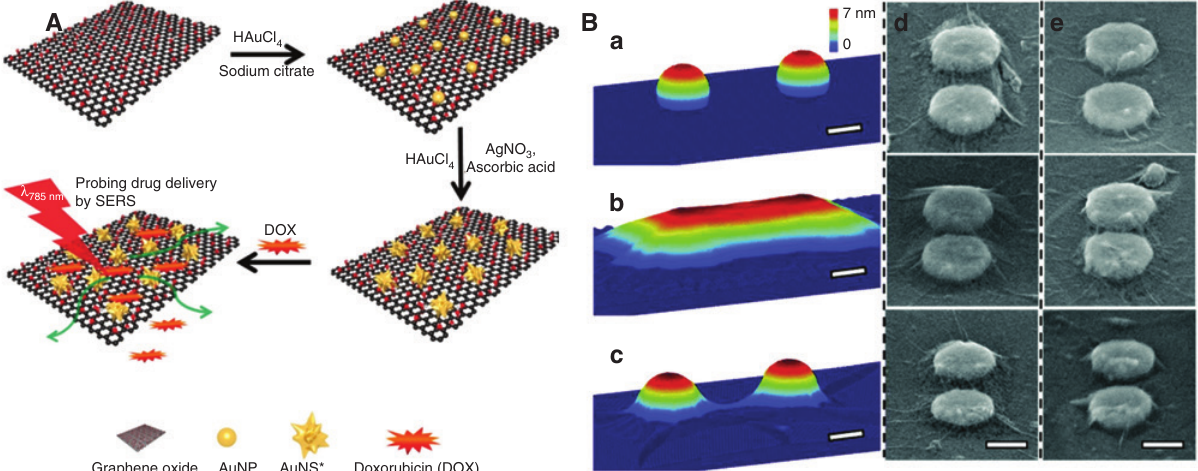
Figure 4: (A) Schematic illustration of the reduced graphene oxide-nanostar (rGO-NS) nanocomposite for drug delivery probed by SERS. Adapted from Wang et al. ACS Appl. Mater. Interfaces 2014c , 6 , 21798–21805. Copyright © 2014 American Chemical Society. (B) (a–c) Molecular dynamics simulations of nanoparticles on the substrate, graphene wrinkles after wet transfer, and laser shock wrapped gra- phene, respectively. Adapted from Hu et al. Nanoscale , 2015 , 7 , 19885–19893, with permission from The Royal Society of